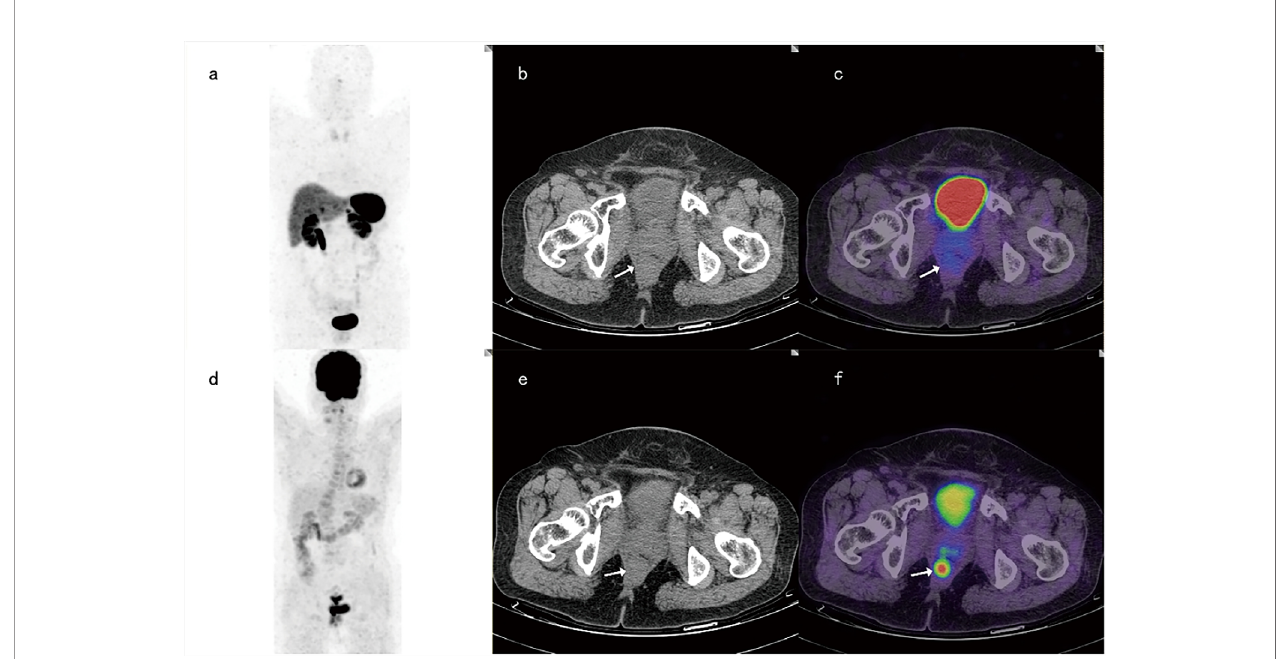
FIGURE 2 | A 65-year-old female patient with rectal neuroendocrine carcinoma (Ki-67 was 90%). 68Ga-DOTANOC PET-CT images and corresponding MIP images (A – C) showed no focal uptake of 68Ga-DOTANOC, while 18F-FDG PET-CT imaging (D – F) showed focal uptake of